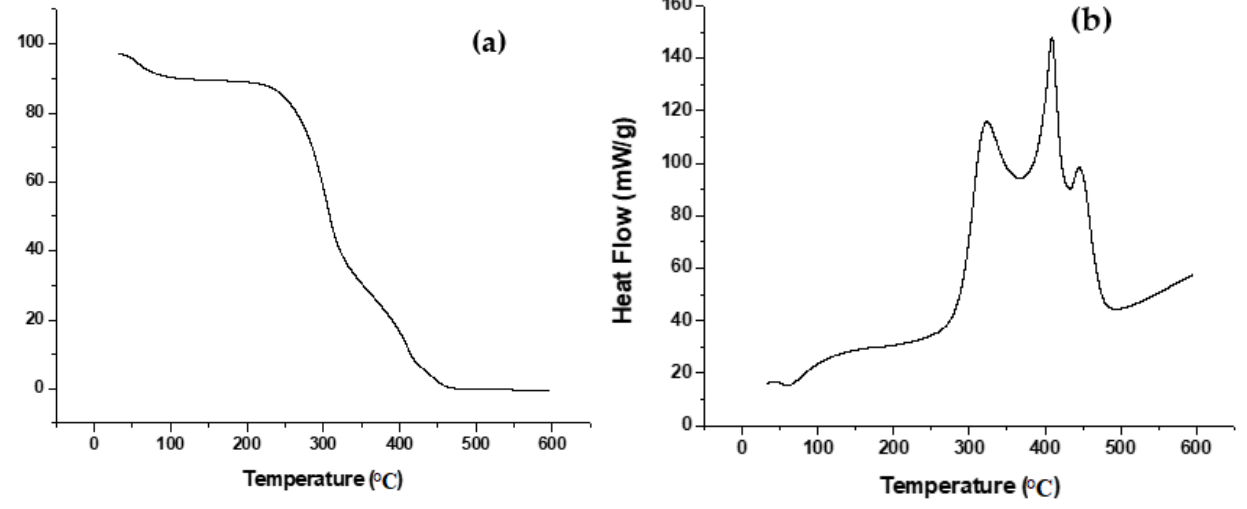
Figure 1. Analysis ( a ) TGA and ( b ) DSC of the cellulose extracted from the CM.